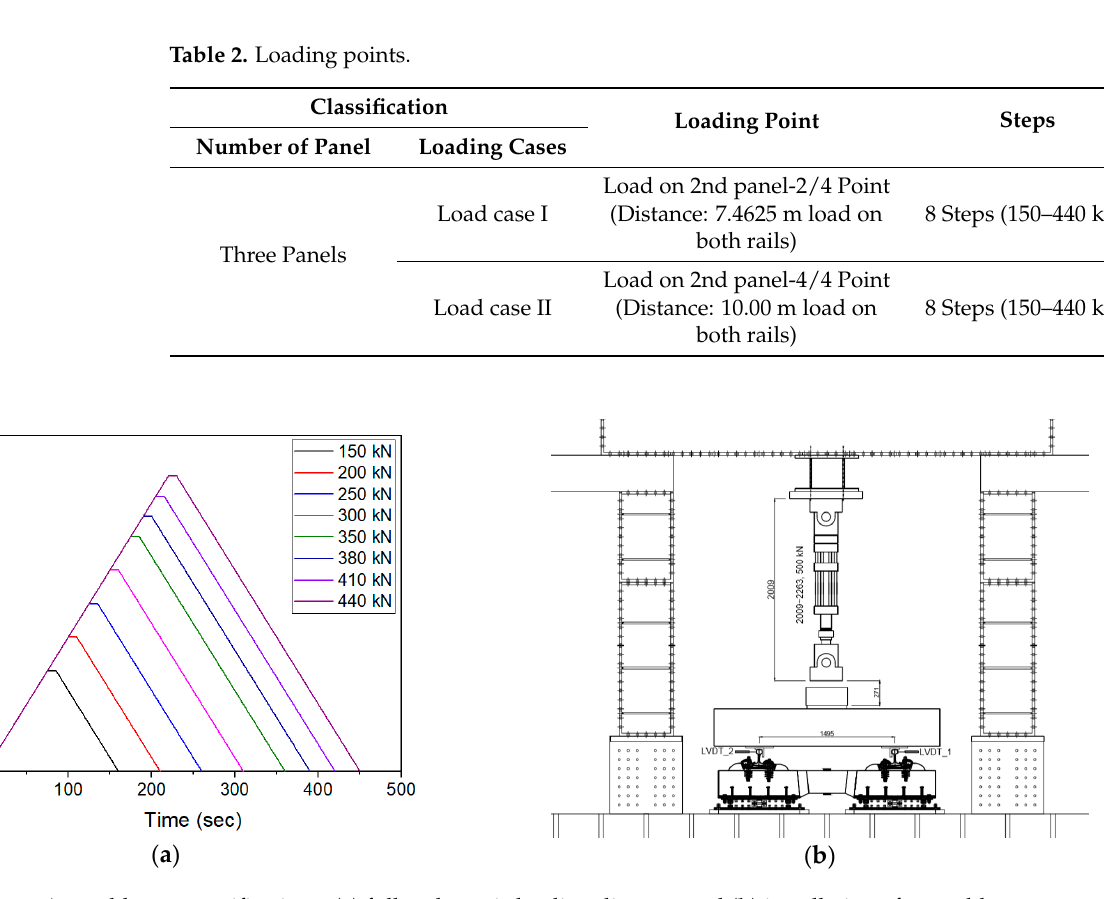
Figure 5. Assembly test specifications: ( a ) full scale static loading diagram and ( b ) installation of assembly test.